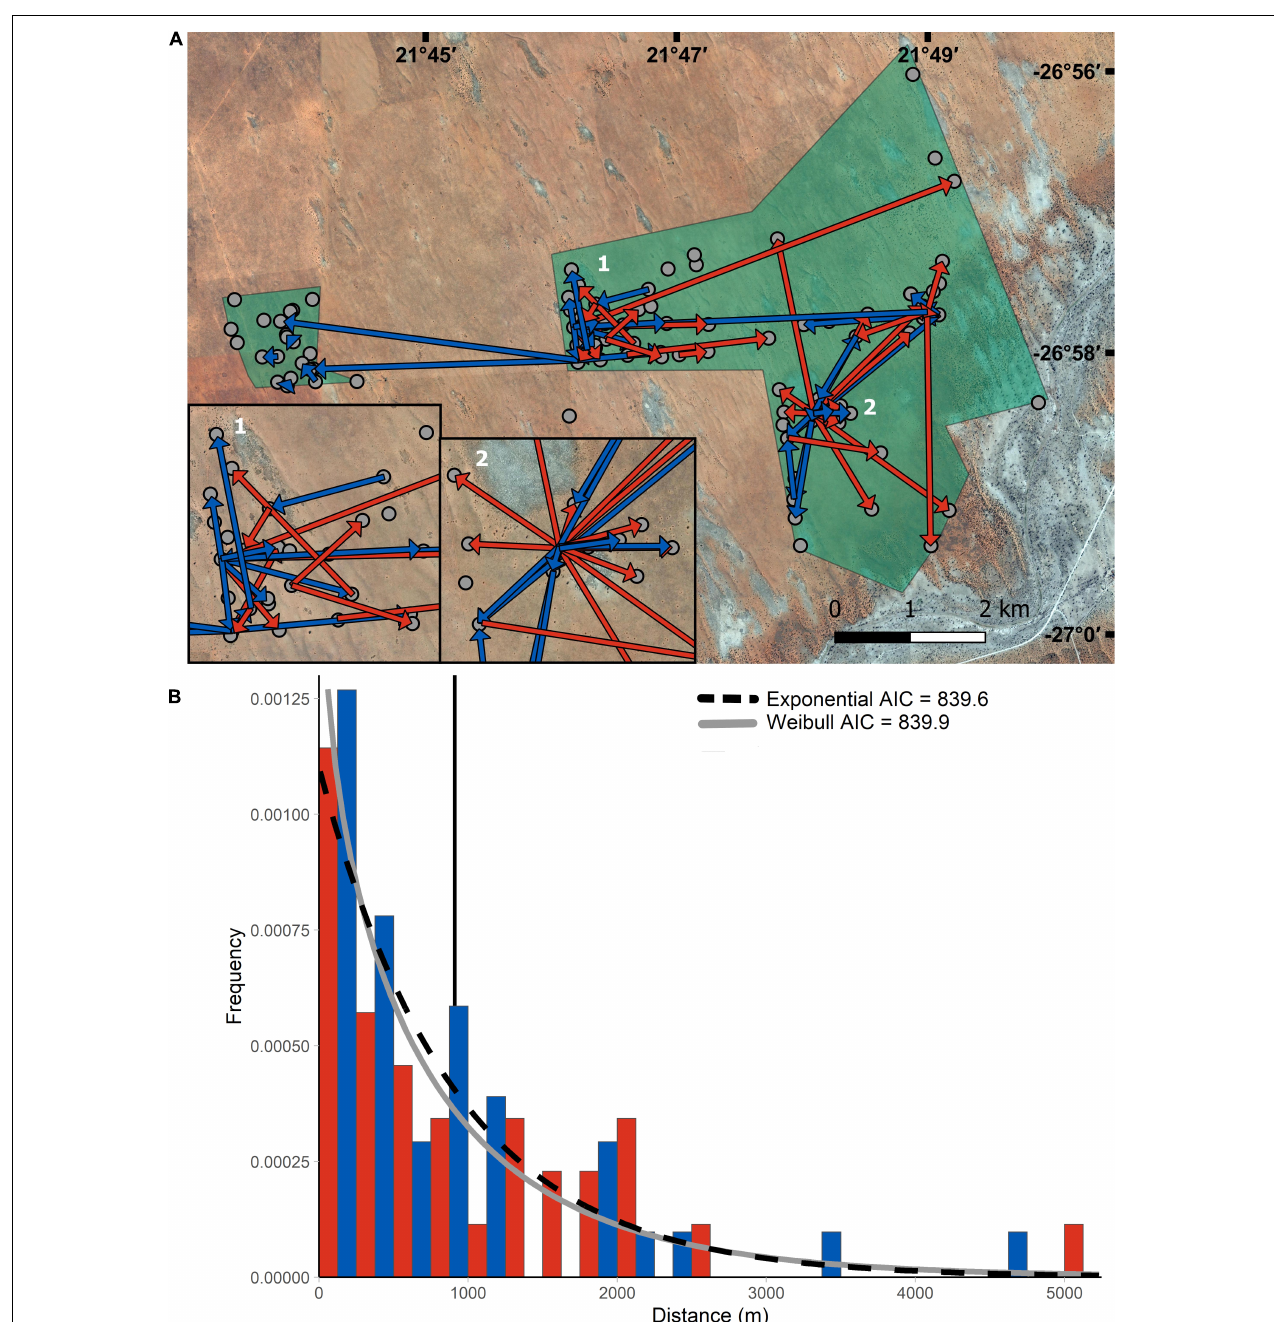
FIGURE 1 | Dispersal distances in Damaraland mole-rats. The distance traveled was measured as the Euclidean distance between the natal group and new location. (A) Direction of travel in female (red), and male dispersers (blue) at the study site (green boxes). Group locations are indicated as gray circles. Inset 1 and 2 enlarge areas of multiple overlapping arrows. The areas we focused our search for dispersers is highlighted in green, with the core area being the larger area to the east. (B) Histogram of distances traveled during natal dispersal by Damaraland mole-rats (males in blue and females in red). The exponential (dashed) and Weibull (gray) density curves are overlaid on the graph. The solid vertical line indicates the mean distance traveled (910 ± 1,004 m). There was no significant difference in the mean distance traveled between the sexes ( n = 76, p -value = 0.30)